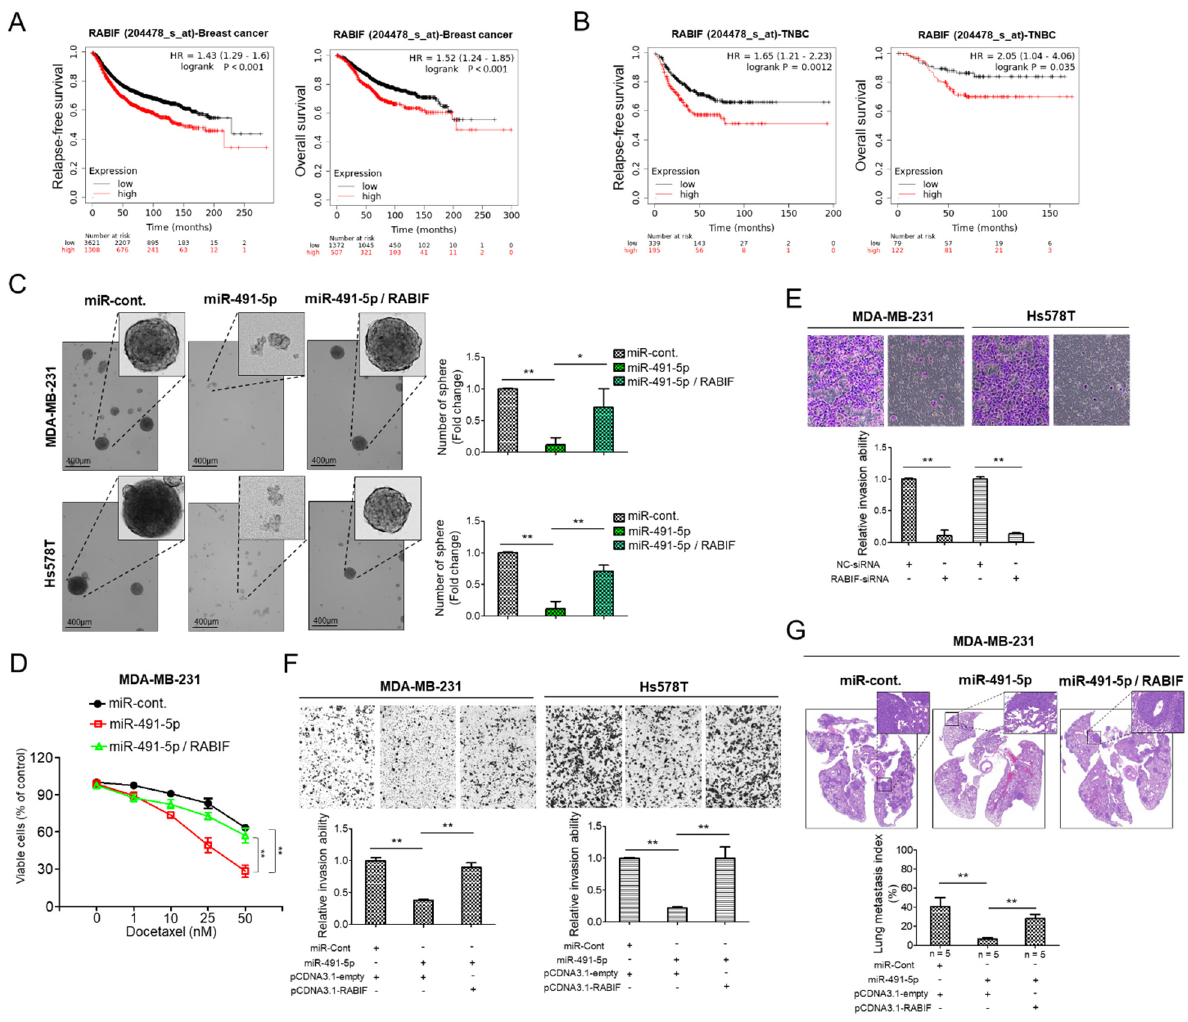
Figure 5. RABIF correlates with poor clinical outcomes and its oncogenic functions can be reverted by miR-491-5p in TNBC. ( A ) Analysis of Kaplan Meier plotter database for RABIF expression in association with relapse-free survival in 4929 breast cancer patients (left) and overall survival in 1879 breast cancer patients (right). ( B ) Analysis of Kaplan Meier plotter database for RABIF expression in association with relapse-free survival in 534 TNBC patients (left) and overall survival in 201 TNBC patients (right). ( C ) Observations of sphere formation under stem cell selective conditions after 8 days of culturing MDA-MB-231 or Hs578T cells transfected with the indicated plasmids (left). Representative images are shown. Quantification of spheres after 8 days of culturing (right). ( D ) MTS assay showing the dose-dependent growth inhibition of MDA-MB-231 cells transfected with the indicated plasmids upon continuous docetaxel exposure at indicated concentrations for 48 h. Each dosage point represents means ± s.e. from three independent experiments (* p < 0.05, ** p < 0.01). ( E ) Boyden chamber assay showing the effect of RABIF-siRNA on TNBC cells’ invasion ability. Representative photographs of invaded cells from different treatments are shown, and quantitative data are denoted by histograms. ( F ) Boyden chamber assay of the invasion ability of TNBC cells transfected with the indicated plasmids or vectors. Repre-sentative photographs show invasive cells under different treatment conditions. Quantitative data are denoted by histo-grams. ( G ) Lung metastasis of five CB17-SCID mice in each group was monitored after tail vein injection of stably RABIF-overexpressing MDA-MB-231 cells or the control cells which were both transfected with miR-491-5p or the control shown by histologic staining and lung metastasis index. All histograms represent means ± s.e. from three independent experiments (* p < 0.05, ** p < 0.01).